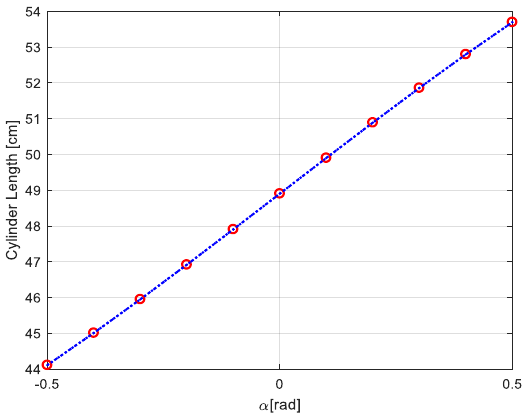
Figure 8. Relation between 𝛼 vs. cylinder’s rod translational motion.